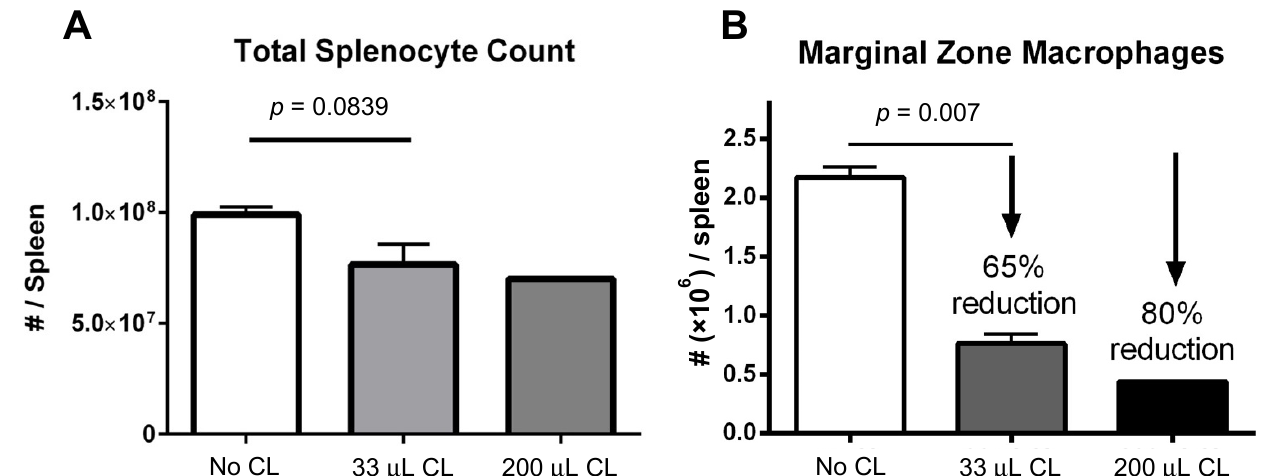
Figure 1. ( A ) Manual count of total numbers of splenocytes following treatment of mice with clodronate liposome treatment (CL) at two different volumes ( n = 4 per group). There appeared to be a greater decline in total splenocyte numbers with the higher dose of clodronate liposomes, but this was not statistically significant. ( B ) Marginal zone macrophage count as assessed by flow cytometry following clodronate liposome treatment. Treatment with 33 µ L of CL yielded a 65% reduction in numbers of marginal zone macrophages. This difference was statistically significant ( p < 0.05). With a higher dose of 200 µ L, marginal zone macrophage numbers could be reduced even further (80%).